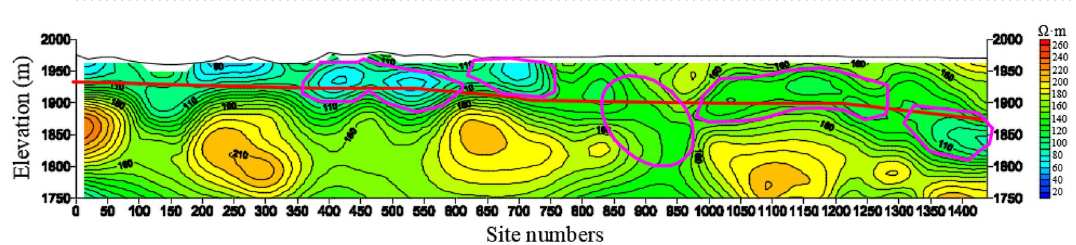
Figure 15. The resistivity profile of the TEM of 220 m mileage cross-section.